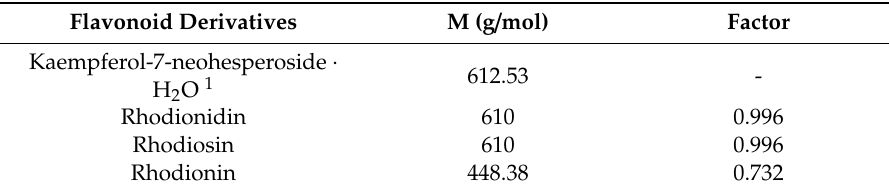
Table 4. Correction factors for quantification of flavonoid derivatives relative to reference standard.